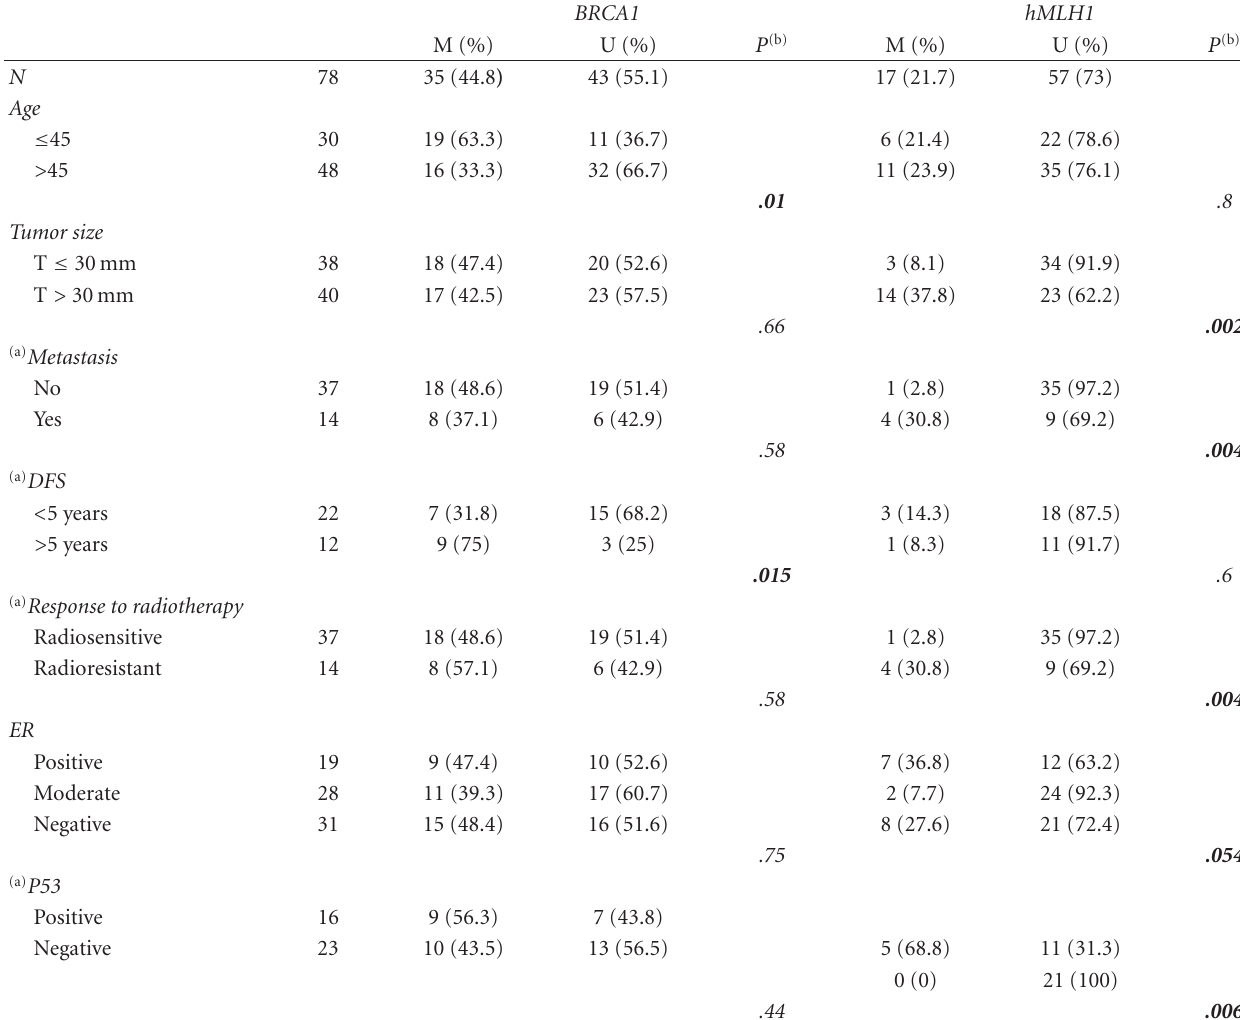
Table 2: Association between gene promoter methylation and clinicopathological features ER and p53 expression in breast cancer.